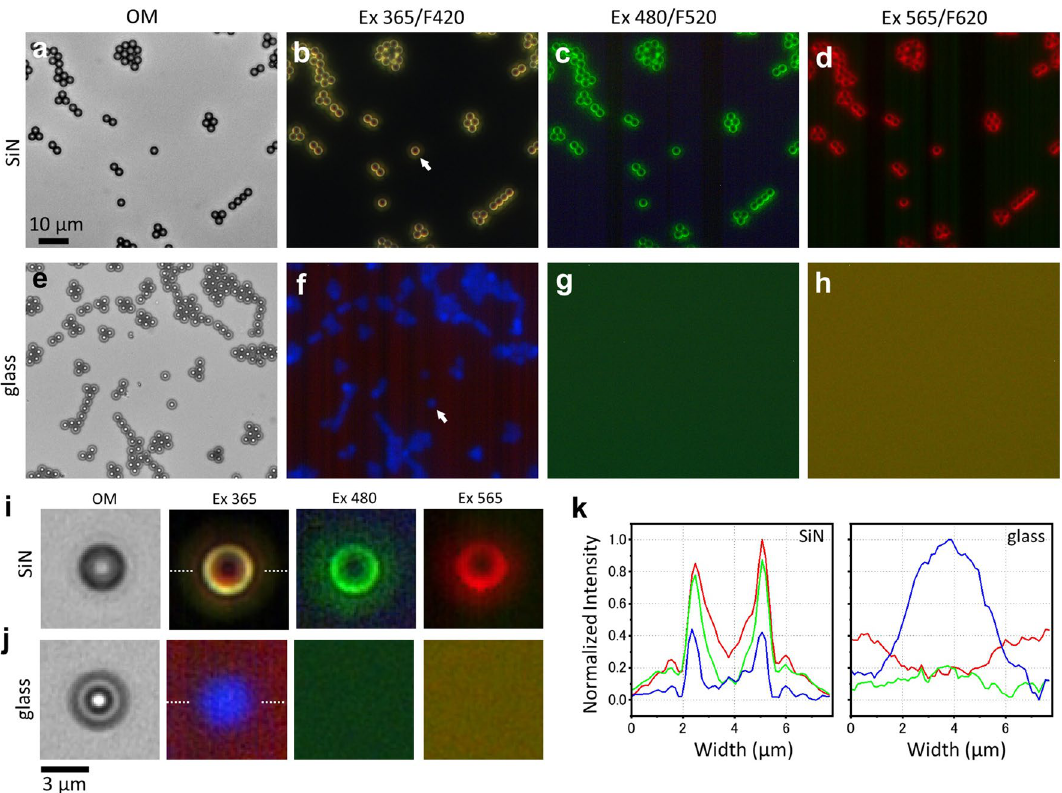
Figure 6. Comparison of PS spheres attached to glass and SiN film by fluorescence microscopy. ( a ) OM image of the 3 μm diameter PS spheres on a 50 nm thick SiN film. ( b – d ) Images of spheres attached to the SiN film using three sets of fluorescence filters with excitation at 365 nm and fluorescence at 420 nm (Ex365/F420), excitation at 480 nm and fluorescence at 520 nm (Ex480/F520) and excitation at 565 nm and fluorescence at 620 nm (Ex565/F620). The PS spheres attached to the SiN film were clearly observed with all three sets of filters. ( e ) OM image of the 3 μm diameter spheres attached to the slide glass. ( f – h ) Images of spheres attached to the slide glass using three sets of fluorescence filters with excitation at Ex365/F420, Ex480/F520 and Ex565/F520. The spheres attached to the glass showed very weak autofluorescence with a set of filters of Ex365/F420, and the sphere structure was not discerned with set of filters of Ex480/F520 or Ex565/F620. ( i ) Magnified OM image and fluorescence filter images of spheres on the SiN film indicated by a white arrow in ( b ). In all fluorescence filter images, ring-like structures were observed around the periphery of the spheres. ( j ) Magnified OM image and fluorescence filter images of the spheres attached to the slide glass indicated by a white arrow in ( f ). ( k ) Comparison of the line plots at the centre of the sphere image using the set of filters, Ex365/F420, on the SiN film and glass. The red, blue and green lines correspond to the RGB intensity values at the white dotted line position at the sphere centre, respectively (dotted line in ( i ) and ( j ) Ex365). The normalised RGB intensities of PS sphere on a SiN film show sharp peaks at the sphere ends (left plot). On the other hand, for the spheres on the slide glass, the blue line shows a dome shape, but the red and green intensity show no spherical structure but just noisy (right plot). Scale bars, 10 μm in ( a ) and 3 μm in ( j